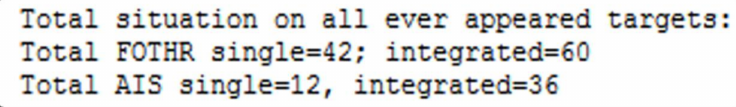
Figure 11. Day log